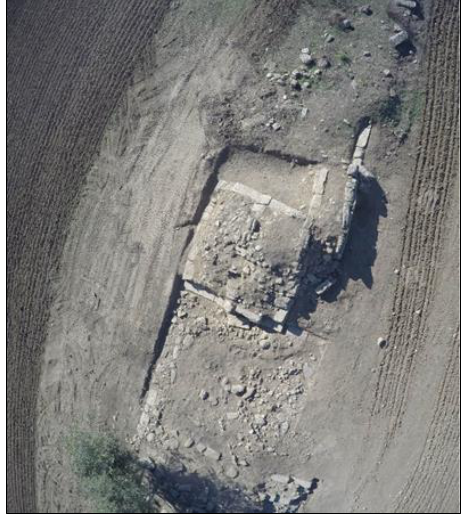
Figure 8. Ancient city wall section, mapping from UAV.